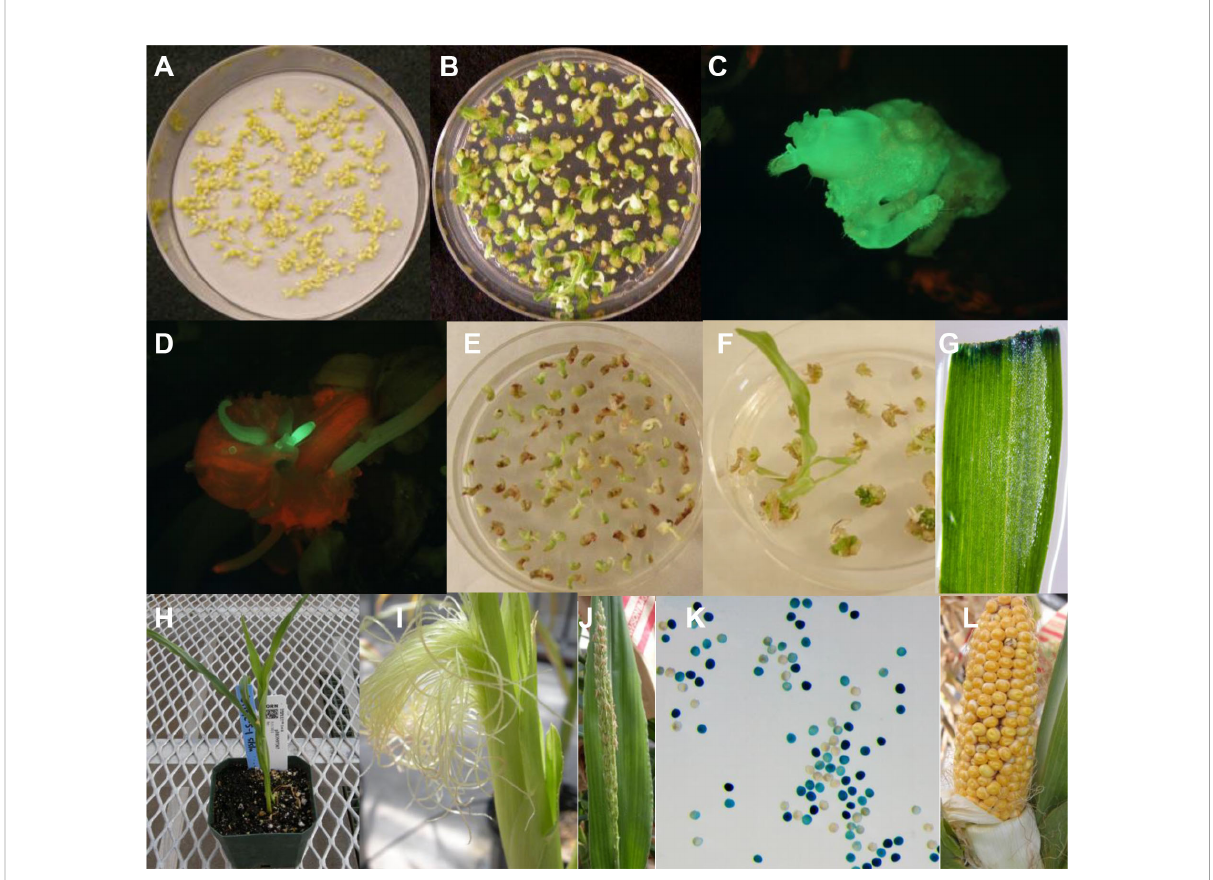
FIGURE 4 Regeneration of fertile events from multiple buds. (A) SEEs after co-culture for 3-6 days; (B) Bud formation from SEEs on bud induction medium 1484 containing 4.0 mg/L BAP and 2.2 mg/L picloram for two weeks; (C) A GFP positive bud formation from SEEs cultured on1484 medium containing 4.0 mg/L BAP and 2.2 mg/L picloram; (D) Elongating buds expressing GFP ; (E) Buds induced on induction medium were transferred to bud proliferation medium 2913 containing 1.0 mg/L 2,4-D, 2.2mg/L picloram, and 25 µM glyphosate for 4 weeks; (F) Regeneration of transgenic plants 2-4 weeks after transfer of resistant buds to regeneration medium 1083 containing 25 µM glyphosate; (G) Leaf from regenerated plants expressing GUS; (H) Transgenic plants in soil pots in greenhouse; (I) Normal silk formation; (J) Normal tassel formation; (K) GUS assay of pollen to con fi rm germline transformation; (L) Normal seed set on transgenic